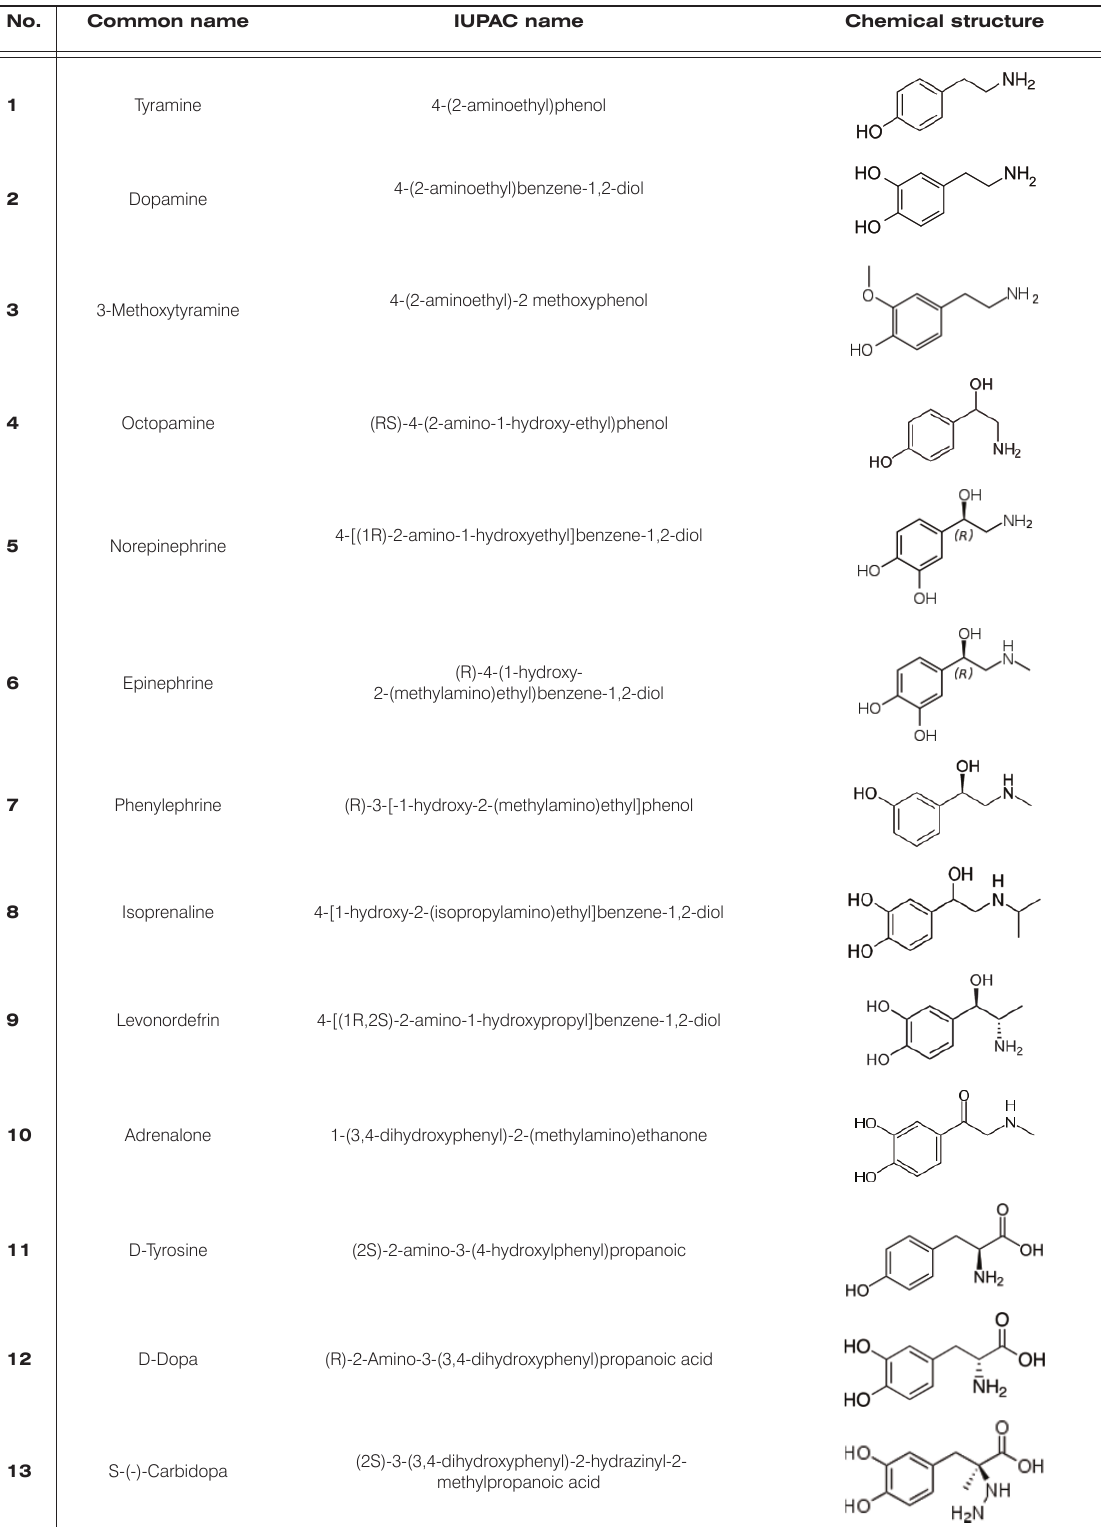
Table 1. Chemical structures of the investigated amines (compounds 1-13).